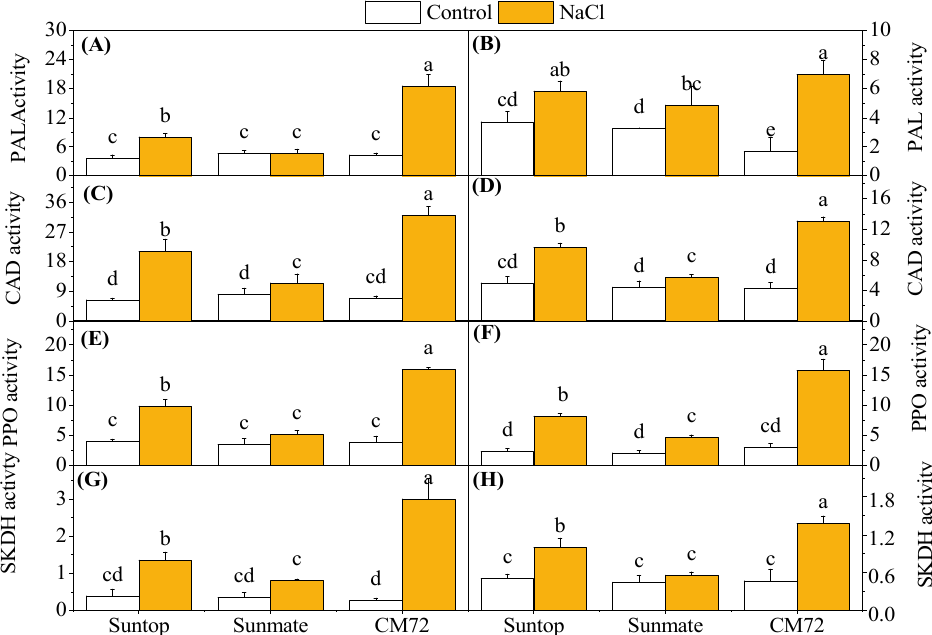
Figure 7. Activities of secondary metabolism-related enzymes: phenylalanine ammonia-lyase (PAL; A , B ) (Unit mg –1 protein), cinnamyl alcohol dehydrogenase (CAD; C , D ) (mol mg –1 protein); polyphenol peroxidase (PPO; E , F ) (Unit mg –1 protein), and shikimate dehydrogenase (SKDH; G , H ) (mol mg –1 protein) in leaves (left panel) and roots (right penal) of two wheat cultivars—Suntop, Sunmate—and barley cultivar CM72, exposed for 7 days to 100 mM of NaCl. Di ff erent letters indicate significant di ff erences ( p ≤ 0.05) between NaCl treatment and control within the two wheat cultivars and barley cv. CM72.